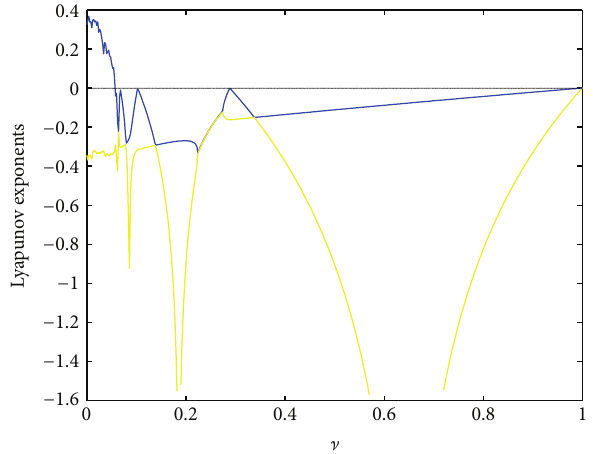
Figure 23: The corresponding Lyapunov exponents with ] ∈ (0,1] , = 2.13 and 𝛼 = 1.46 . 𝛼 1 2